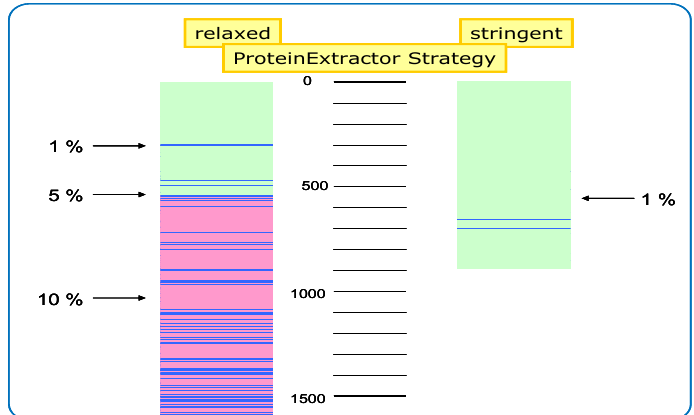
Fig. 4: ProteinExtractor setups. The more relaxed score criteria lead to a longer protein list with more False Positives. The blue lines mark the artificial protein entries in the composite database. The green and the red area mark the ranges with a False Discovery Rate below and above 5